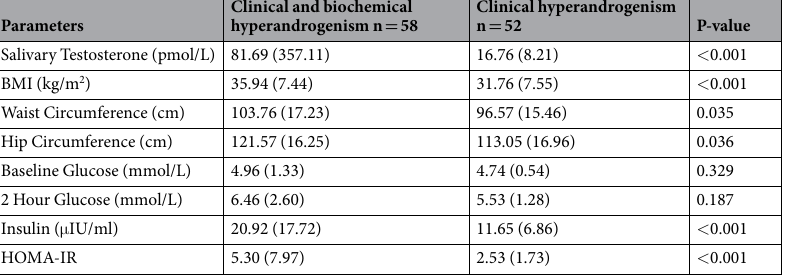
Table 2. Comparison of PCOS women with both biochemical and clinical hyperandrogenism versus PCOS women isolated clinical hyperandrogenism. Values in (mean (SD)). HOMA-IR – homeostatic model assessment – insulin resistance. BMI – Body Mass Index . Comparison of PCOS women with both biochemical and clinical hyperandrogenism (raised serum T and/or a raised FAI) compared to those PCOS women with clinical hyperandrogenism (no elevated serum androgen level). As shown in this analysis, PCOS women with both biochemical and clinical hyperandrogenism showed a more metabolic phenotype compared to those PCOS women with clinical hyperandrogenism alone.